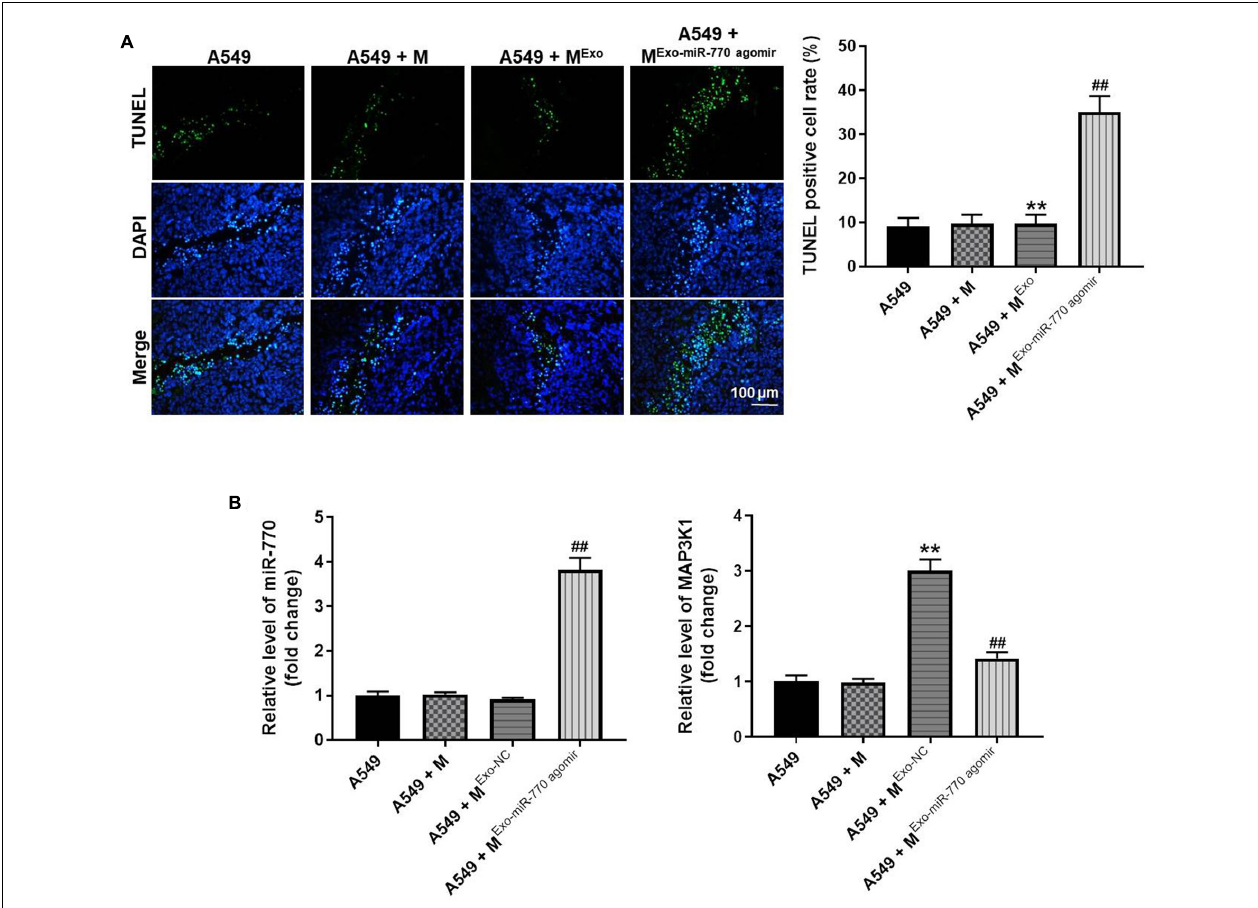
FIGURE 9 | Exosomal miR-770 significantly induced the apoptosis in tumor tissues of mice via suppressing the M2 polarization of macrophages. (A) The apoptosis in tumor tissues was detected by TUNEL staining. (B) The levels of miR-770 and MAP3K1 in tumor tissues of mice were investigated by RT-qPCR. N = 6; ** P < 0.01 compared to A549 cells, ## P < 0.01 compared to A549 + M Exo